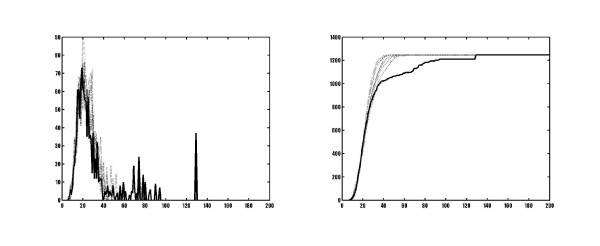
Fluffy-tailed knirps distribution. (Left) The distribution of the original regulatory knirps sequence: (solid line); the distribution of 10 randomised sequences (dotted lines). (Right) The same distributions in cumulative form. The X axis shows the size of lists of similar words, the Y axis is the number of lists.